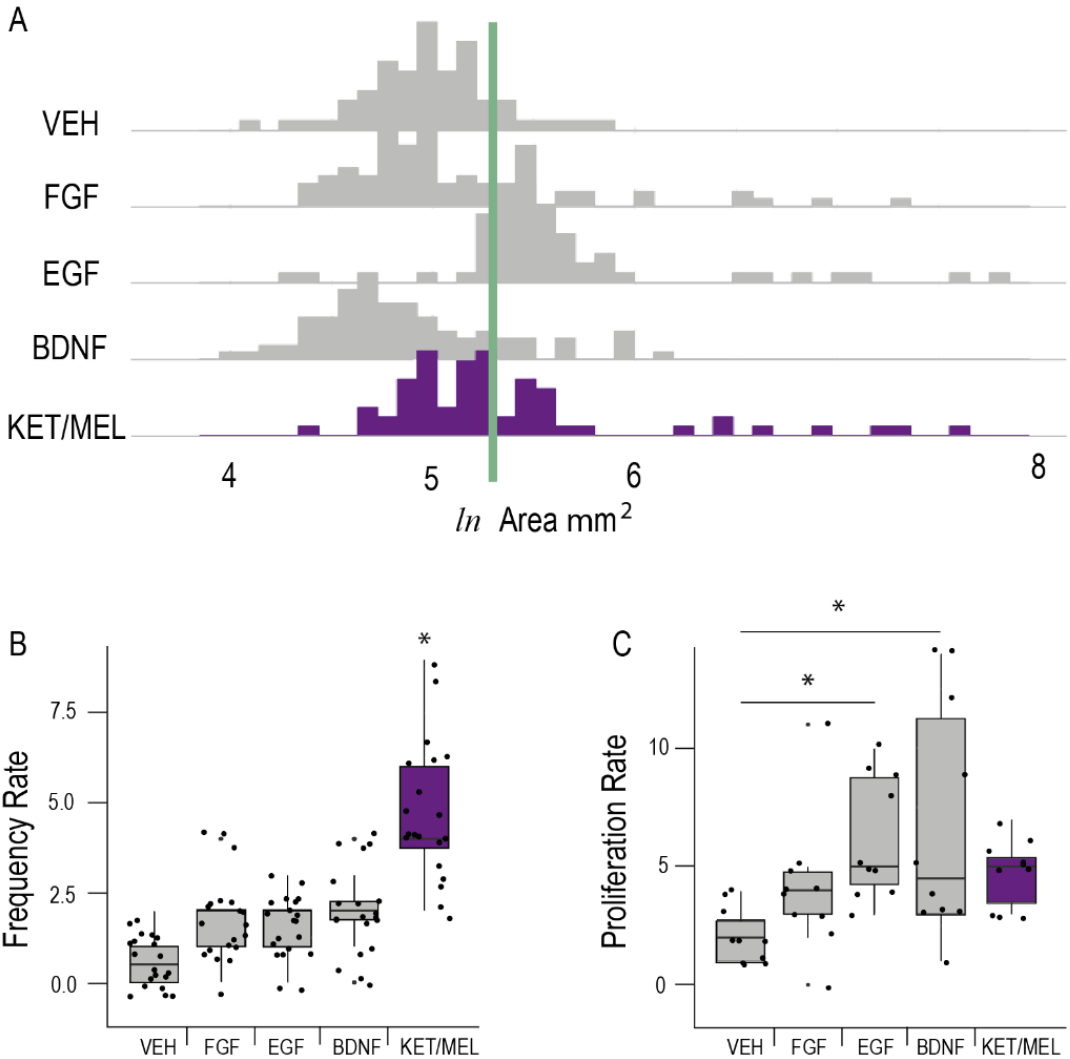
Figure 5. Comparison of the effects of KET/MEL combination with the effects of growth factors on neurogenesis. Olfactory neuronal precursors were cultured with the vehicle (VEH), fibroblastic growth factor (FGF), epidermal growth factor (EGF), brain-derived neurotrophic factor (BDNF) or the combination of ketamine and melatonin (KET/MEL) during 6 h. The cluster area (Panel A ); the frequency of cluster formation (Panel B ); and the proliferation rate (Panel C ), were determined as described in the Materials and Methods section. The experiment was repeated twice, and data were analyzed using Kruskal–Wallis test followed by Dunn´s multiple comparison test. Results are expressed as median ± Tukey intervals. *Asterisks indicate significant differences with p < 0.05.